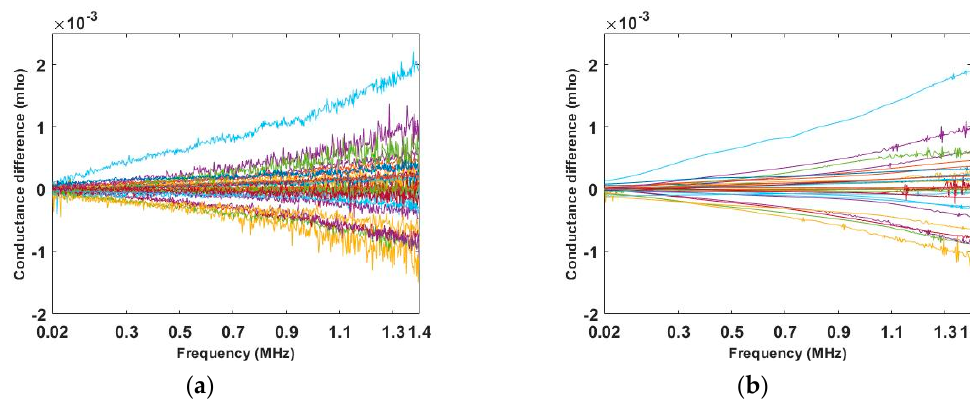
Figure 12. ( a ) Initial conductance measurement differences, for all 36 measuremnets. ( b ) Conductance measurement difference with noise removed for all 36 measuremnets